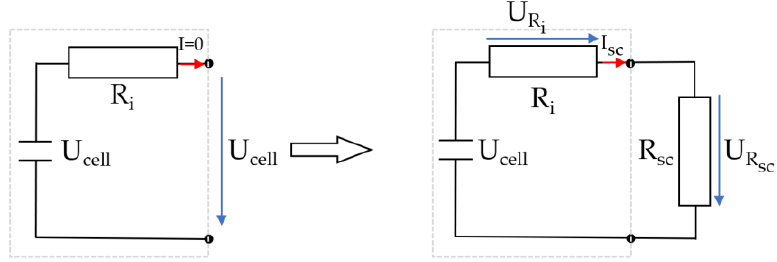
Figure 7. Relationship between internal resistance and short-circuit resistance .